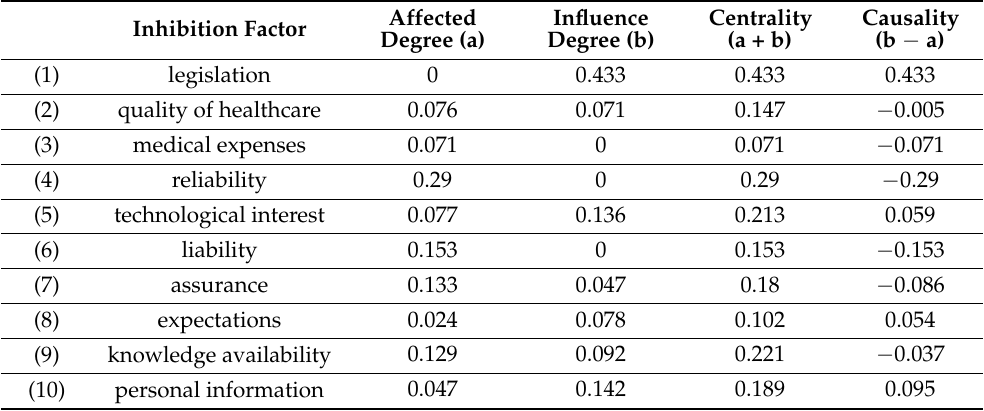
Table 4. Indicators of inhibiting factors identified by the decision-making trial and evaluation la- boratory method.